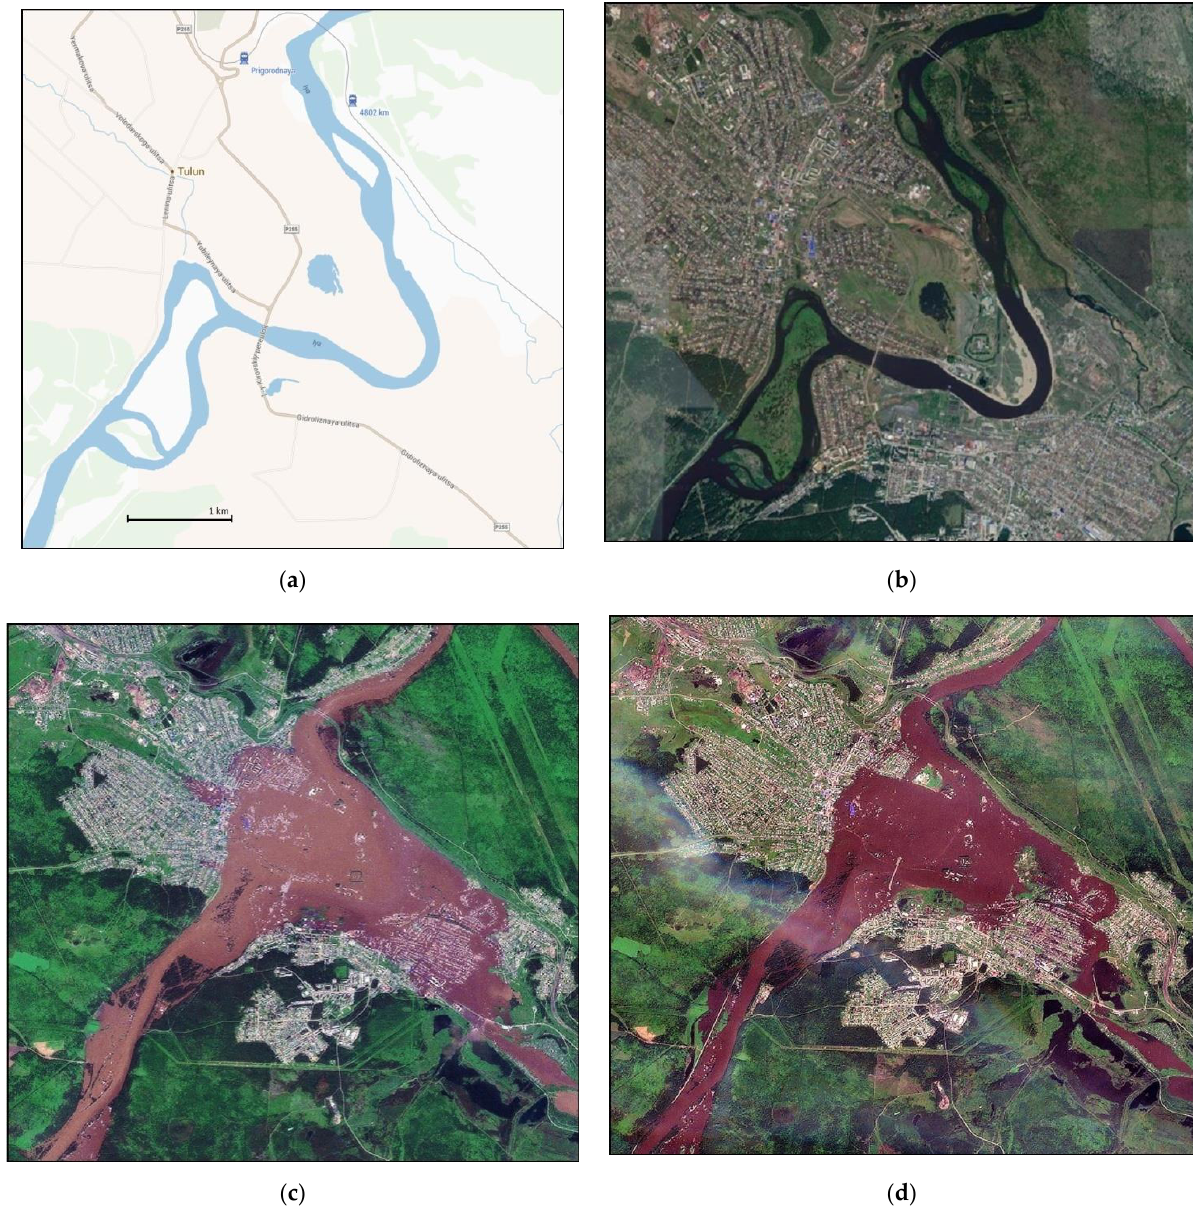
Figure 7. Schematic map of the town of Tulun ( a ), as well as satellite images of the territory during the low-water period ( b ), 29 June ( c ), and 31 July ( d ), 2019 according to the Sentinel-2A satellite. Since the seasonal snow cover in the second half of June is not typical in the Iya River basin, snowmelt runoff cannot be the reason for the generation of these floods. The version with the spread of the backwater from the Bratsk reservoir is also false, because